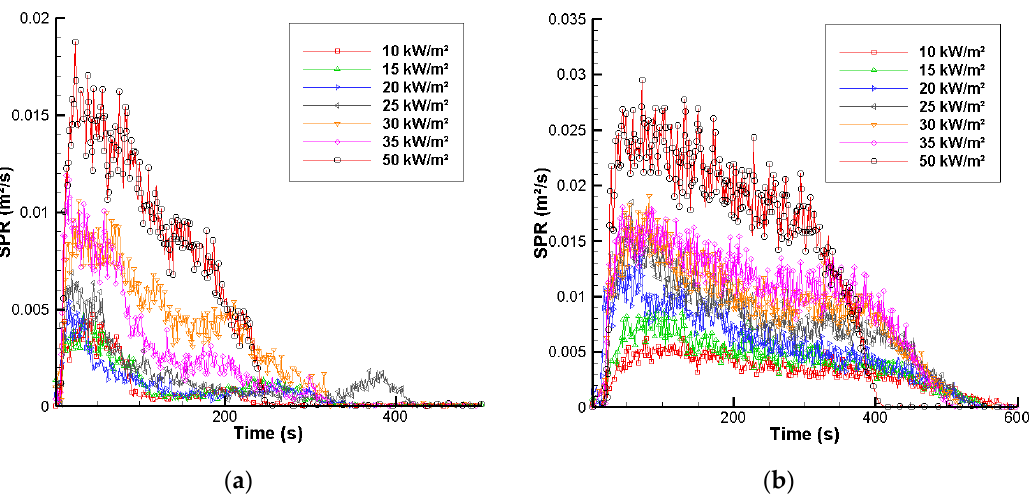
Figure 7. Smoke Production Rate (SPR) as a function of time for different imposed heat fluxes for ( a ) wood and ( b ) thermoplastic samples.